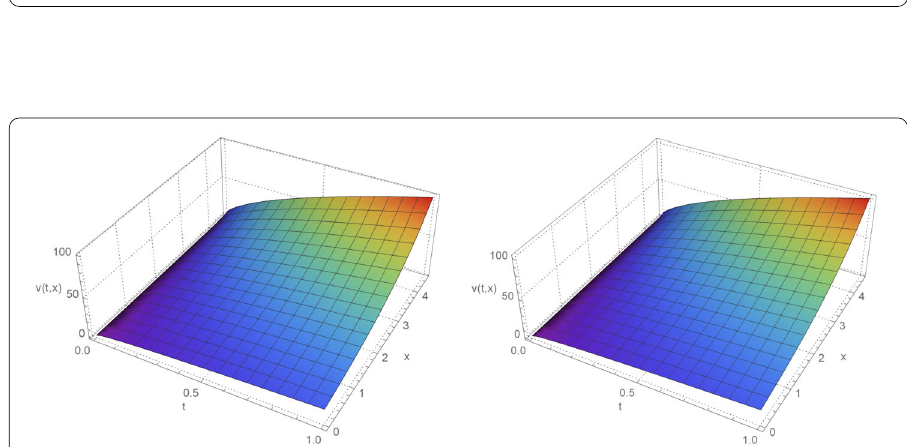
Figure 9 RPSM vs. q-HAM for Case II for V (2) ( t , x ) with β = 0.1, γ = 0.1 and α = 0.35